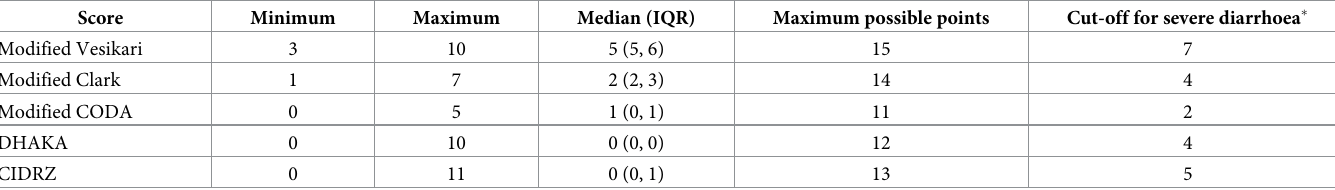
Table 5. Summary of